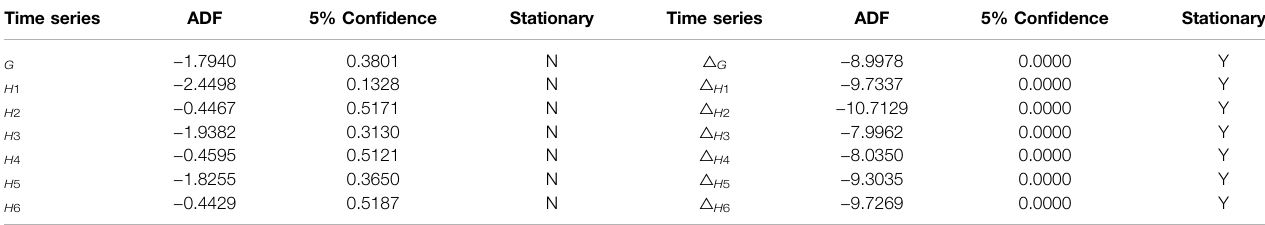
TABLE 1 | Results of stationary test for DTSZ with high loss rate.